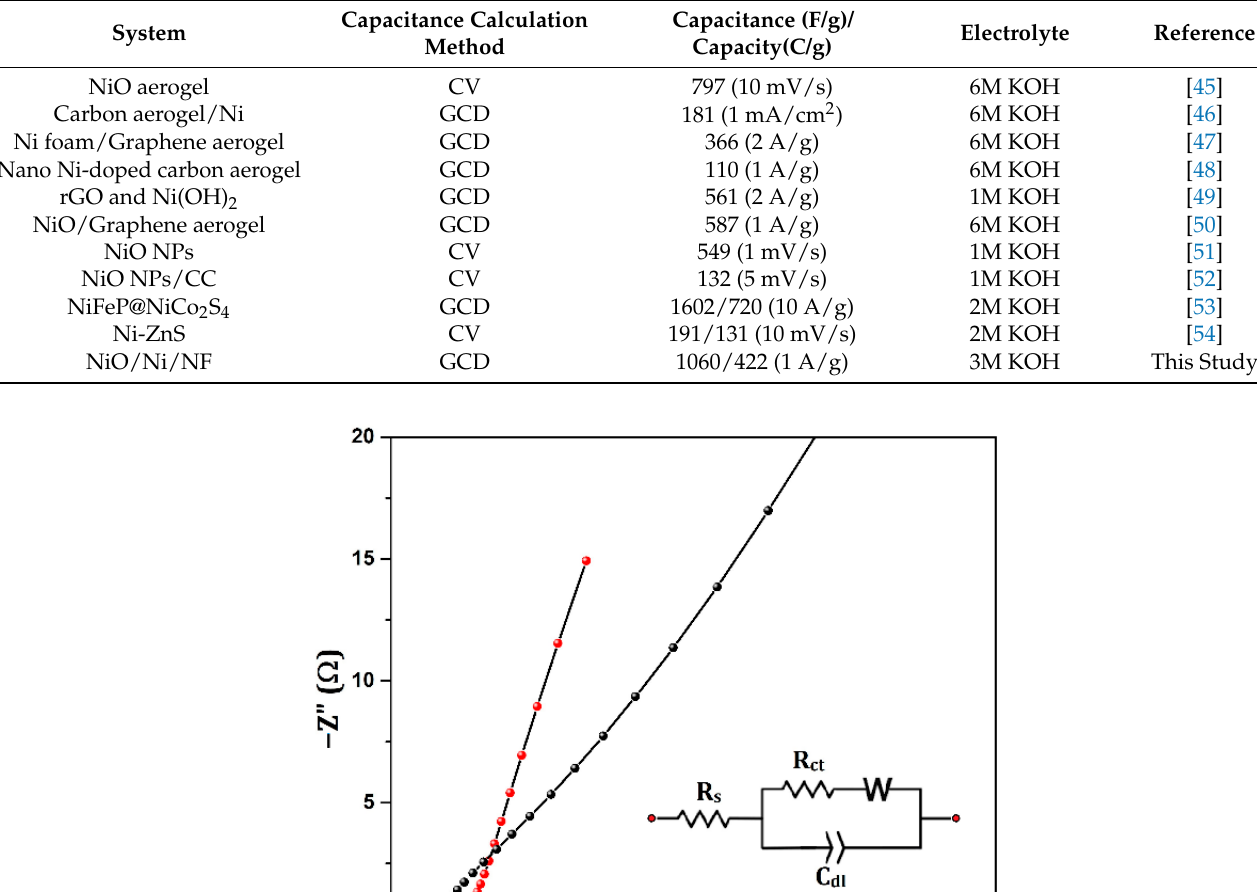
Table 1. Comparison of various aerogel-based supercapacitor electrodes and their performances.